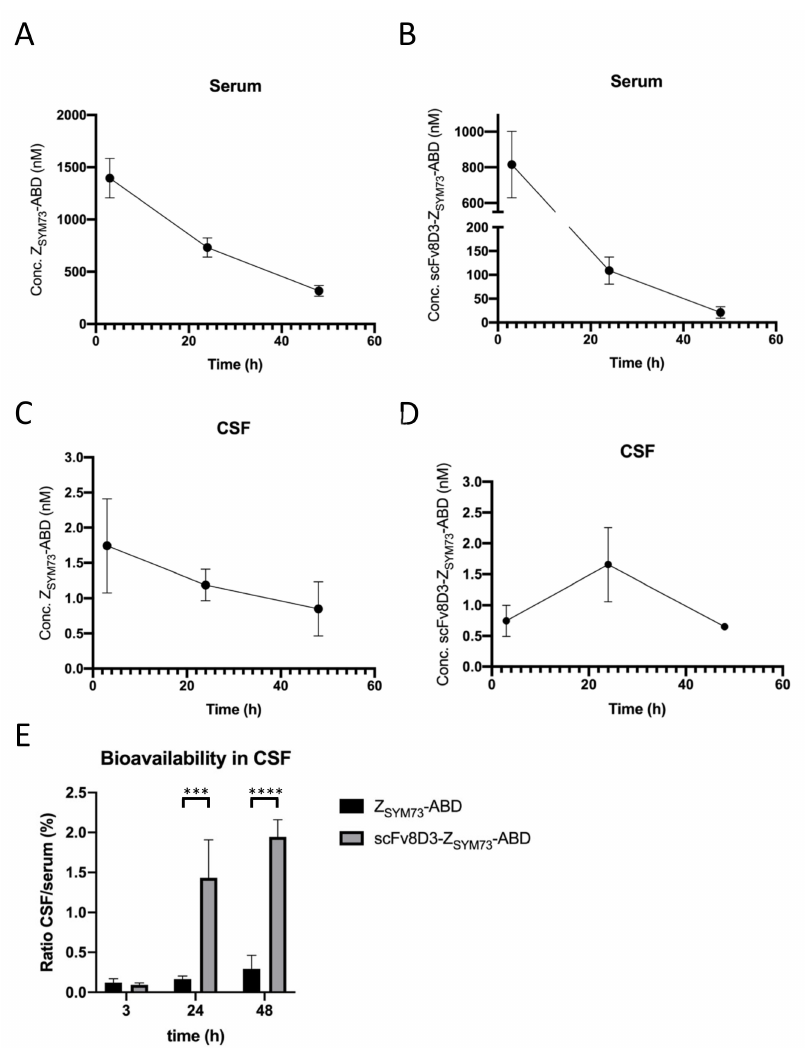
Figure 4. Concentrations of Z SYM73 -ABD and scFv8D3-Z SYM73 -ABD in NMRI mouse serum and CSF at 3 h, 24 h, and 48 h post administration. ( A ) Pharmacokinetic profile of Z SYM73 -ABD in mouse serum. ( B ) Pharmacokinetic profile of scFv8D3-Z SYM73 -ABD in mouse serum. ( C ) Pharmacokinetic profile of Z SYM73 -ABD in mouse cerebrospinal fluid (CSF). ( D ) Pharmacokinetic profile of scFv8D3-Z SYM73 -ABD in mouse CSF. ( E ) Bioavailability in CSF, expressed as CSF-to-serum ratio, of Z SYM73 -ABD and scFv8D3-Z SYM73 -ABD at 3 h, 24 h, and 48 h post administration. Unpaired t tests on data from 24 and 48 h demonstrated significant di ff erences between CSF / serum ratios for Z SYM73 -ABD and scFv8D3-Z SYM73 -ABD (*** p value ≤ 0.001, **** p value ≤